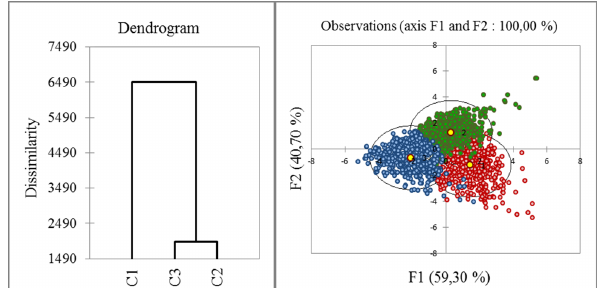
Figure 5. Classification of the different observations from the OHP lidar. Left panel: dendrogram of the dissimilarity index between the observations performed by the hierarchical agglomerative clustering method. Right panel: observations along two discriminant axes, F1 and F2, which represent a linear combination of the different cirrus clouds parameters used in the HAC. Class 1, 2 and 3 are respectively represented by blue, green and red dots.